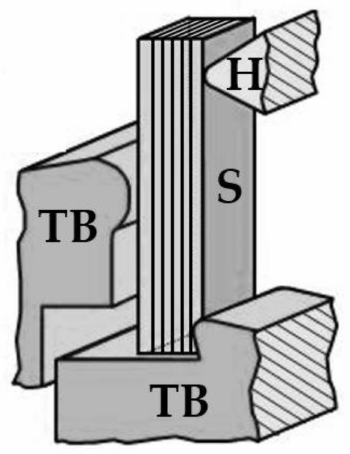
Figure 3. Schematic Dynstat impact strength test set-up for an unnotched sample (S) fixed between two thrust blocks (TB) and punched by a hammer (H). The applied force is perpendicular to the layer interfaces, adapted from